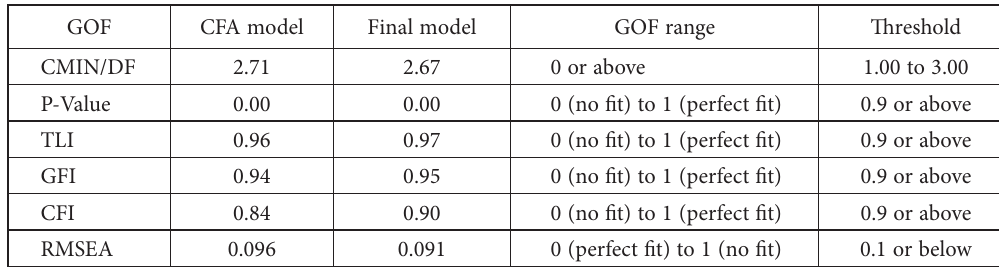
Table 3. Fitness indicators of CFA and the final